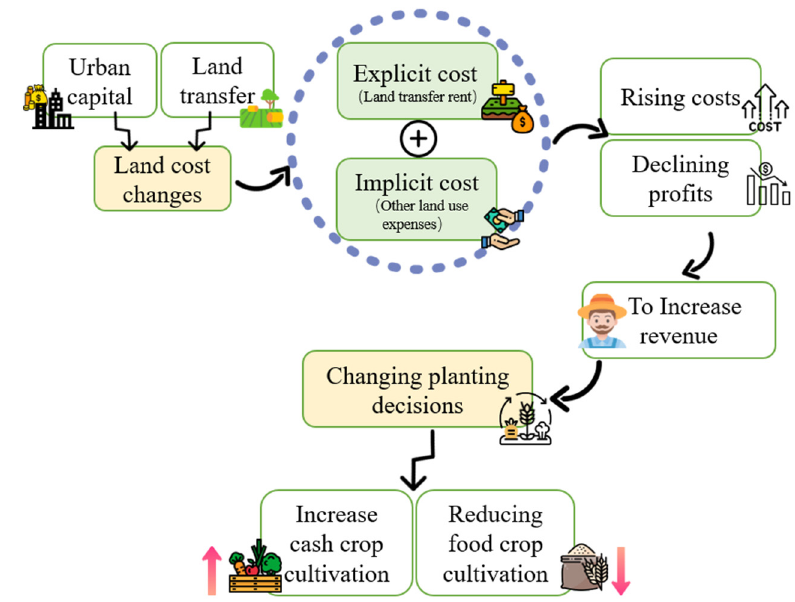
Figure 1. The framework of land costs and crop choice of farmers.